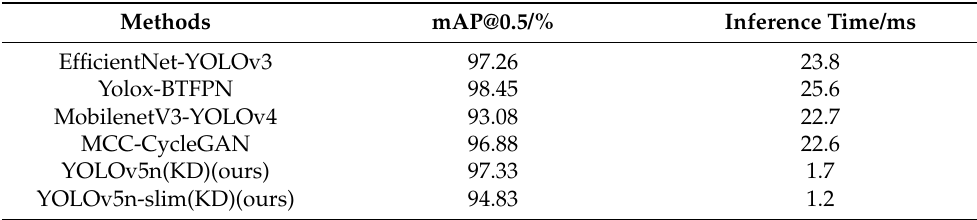
Table 7. Comparison with other model detection